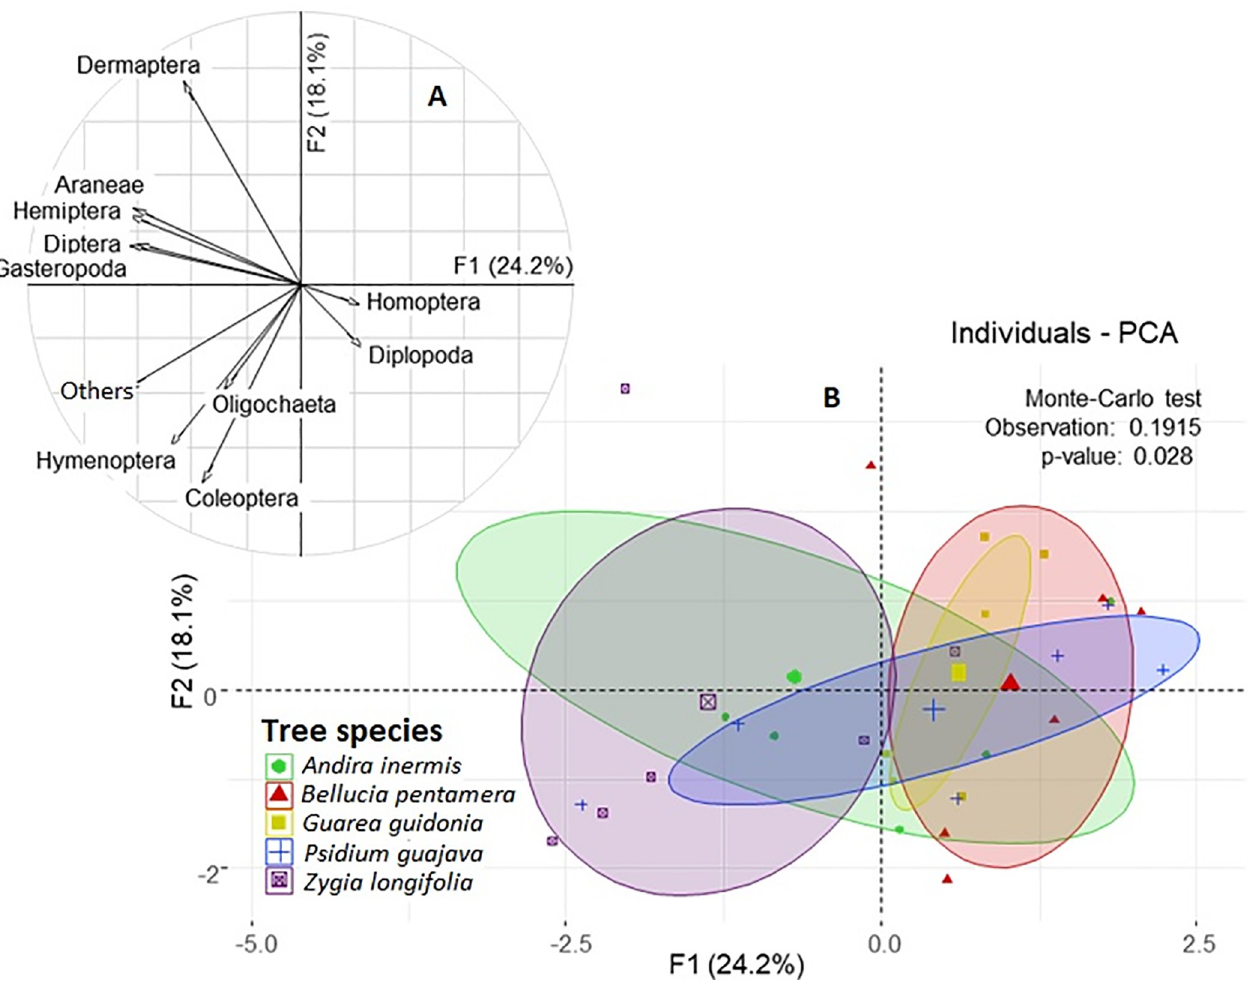
Fig 5. Projection on the factorial plane of the first two axes of a principal component analysis of the edaphic macrofauna variables and of the sampling points grouped according to tree species. A. Correlations of edaphic macrofauna groups. B. Sorting of samples by macrofaunal variables and identified by tree